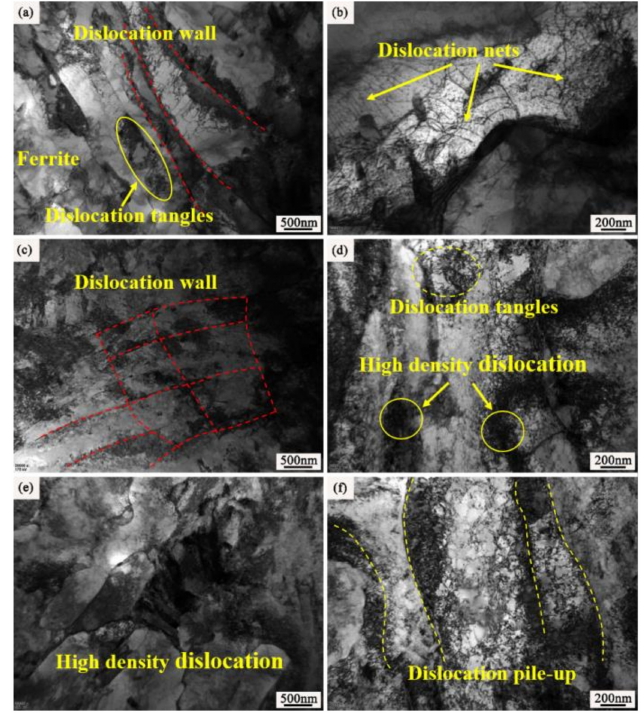
Figure 7. TEM observation of non-carburized samples after ion implantation—( a , b ) non-implanted sample; ( c , d ) lanthanum-implanted sample; and ( e , f ) yttrium-implanted